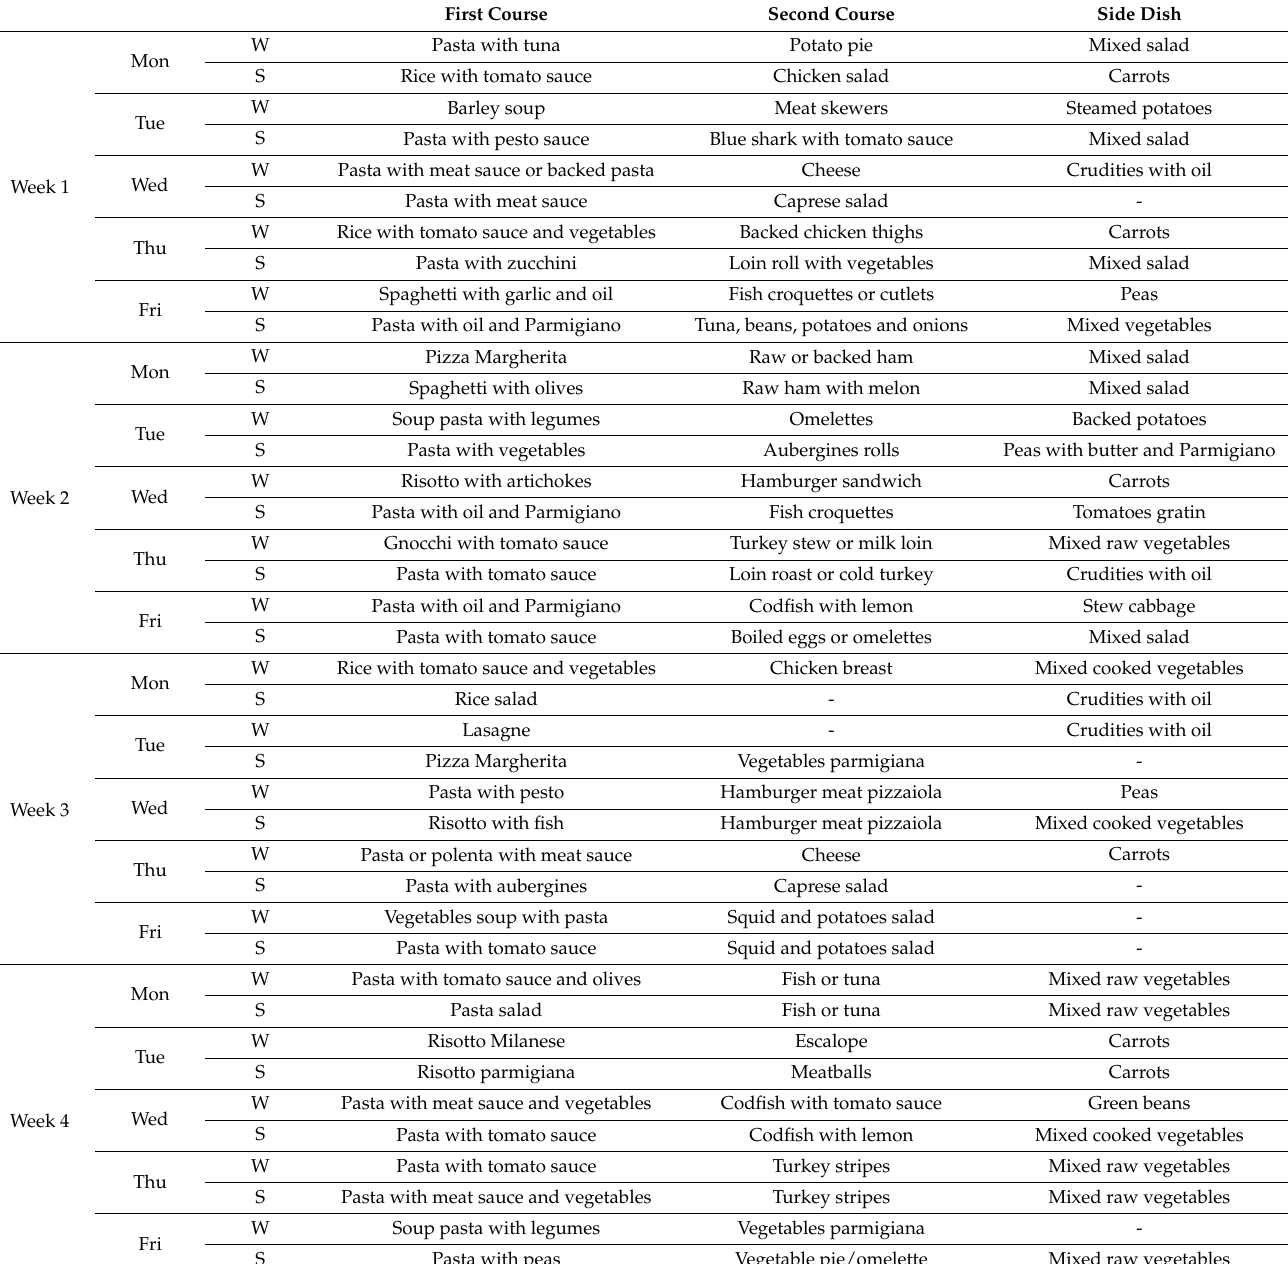
Table 1. List of dishes of the winter (W) and summer (S) menu of schools in the municipality